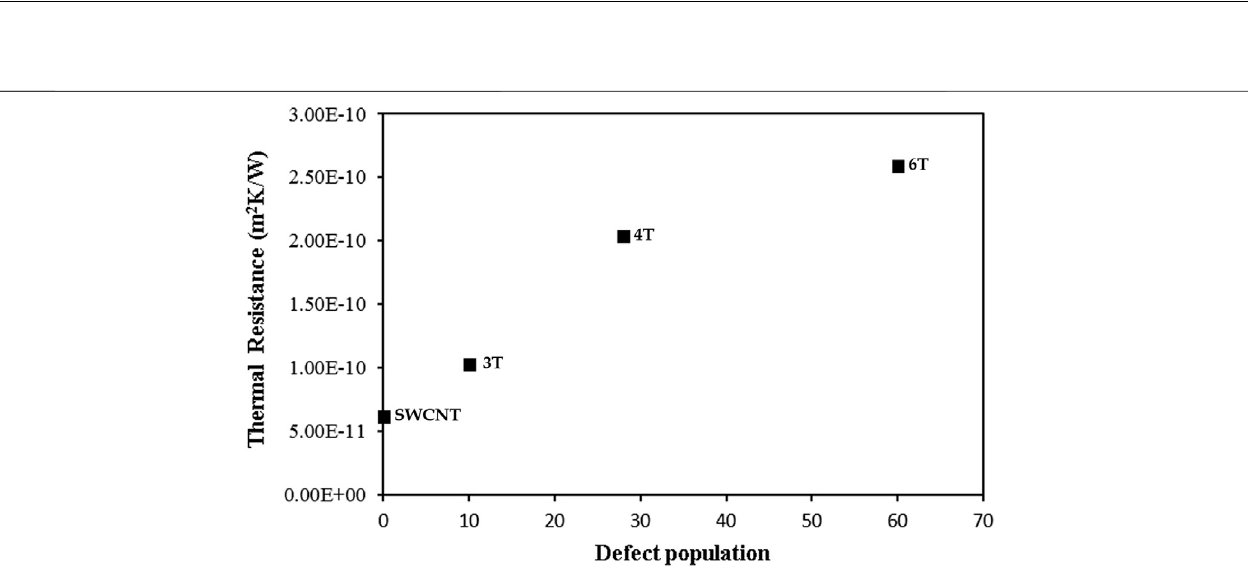
FIGURE 11 | Thermal resistance and defect population in multi-terminal